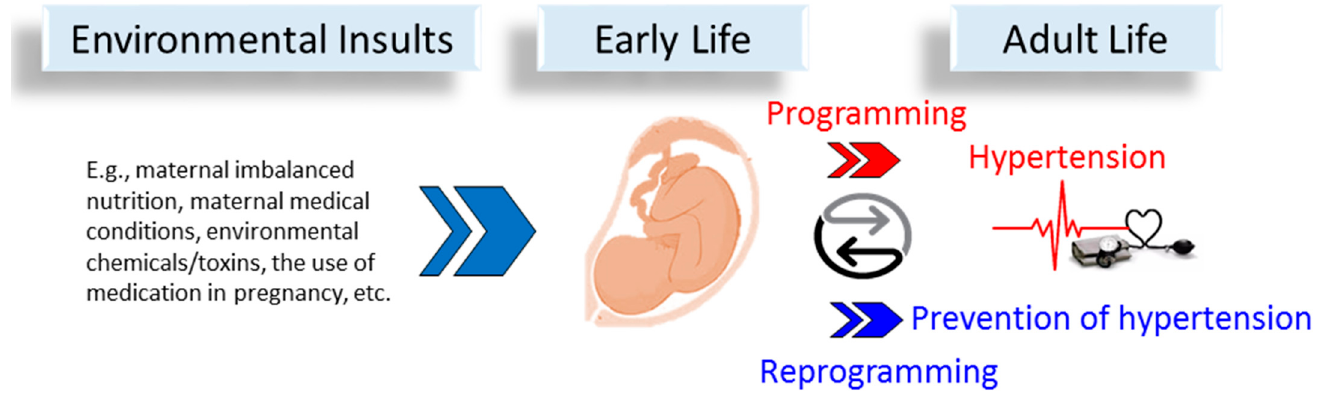
Figure 1. Schema outlining the environmental insults in early life that may induce developmental programming, leading to hypertension in adult life. Conversely, early reprogramming intervention could prevent the development of hypertension in later life.